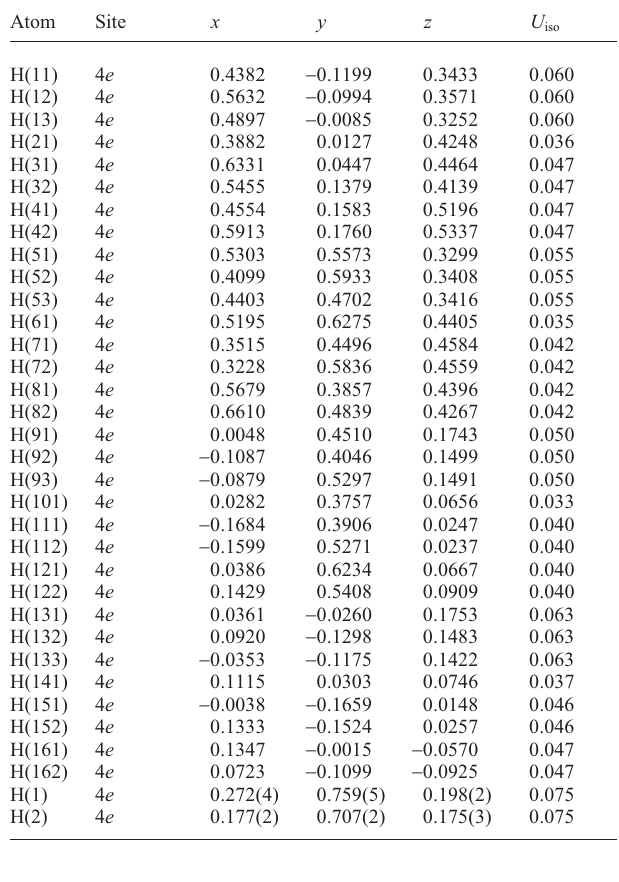
Table 2. Atomic coordinates and displacement parameters (in Å 2 ) .